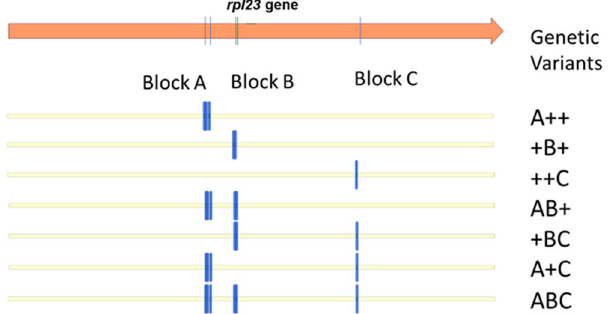
Figure 3. Representation of the potential genetic variants in the rpl23 gene. A, B and C represent the polymorphic positions in the cpm rpl23 gene (blocks A, B and C). + corresponds to the wild type sequence.